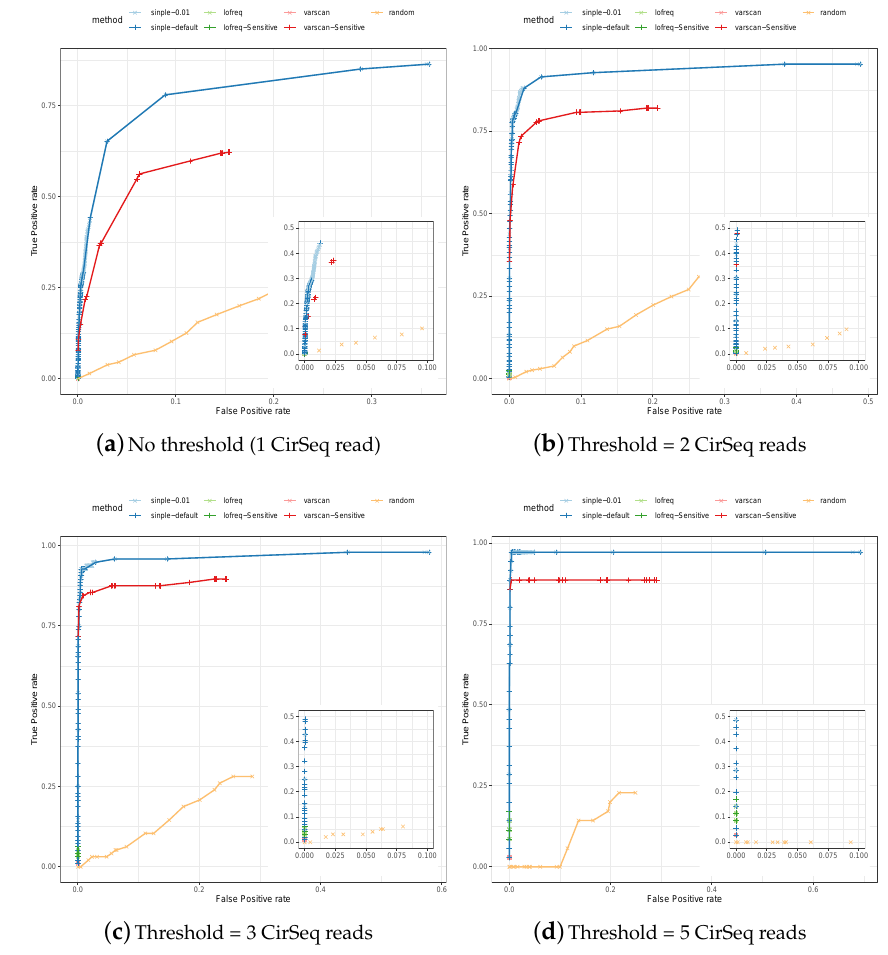
Figure 3. The Receiver-Operator Curves (ROCs) for the specificity and the sensitivity of variants predicted by SiNPle, LoFreq, VarScan2 (both standard and sensitive mode), and a control method based on the random selection of variable positions on the genome irrespective of whether they are true variants or not (see Section 2), from an input of 100,000 reads randomly extracted from a poliovirus dataset sequenced with CirSeq [19]. CirSeq allows the experimental discovery and validation of very low-frequency variants present at population level. The figures were obtained by setting different thresholds on the lists of true and false positives identified by calling consensus on CirSeq reads (see Section 2). All the three methods were run in both a default and a sensitive mode (see Section 2 for their